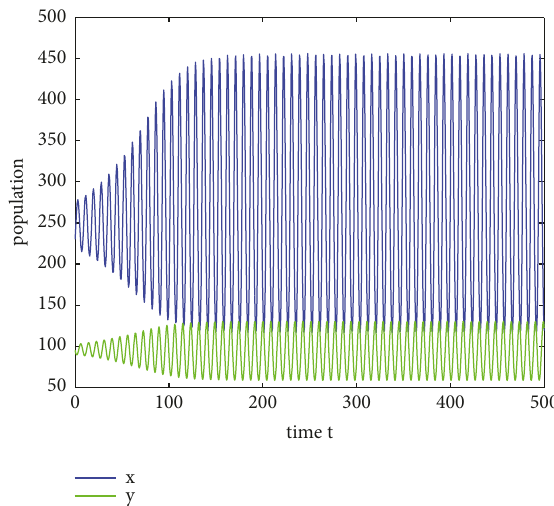
Figure 9: A Time series diagram for prey and predator. Existence of periodic solution around the interior equilibrium 𝐸 ∗ = (𝑥 ∗ , 𝑦 ∗ ) for delayed model (3) with the time delays 𝜏 1 = 0.25 and 𝜏 2 = 0 , where the parameter values are 𝑥(0) = 230 , 𝑦(0) = 95 , 𝐴 = 0.01 , 𝑟 = 2.65 , 𝐾 = 900 , 𝑎 = 0.02 , 𝑐 = 0.215 , and 𝑚 = 1.06 .